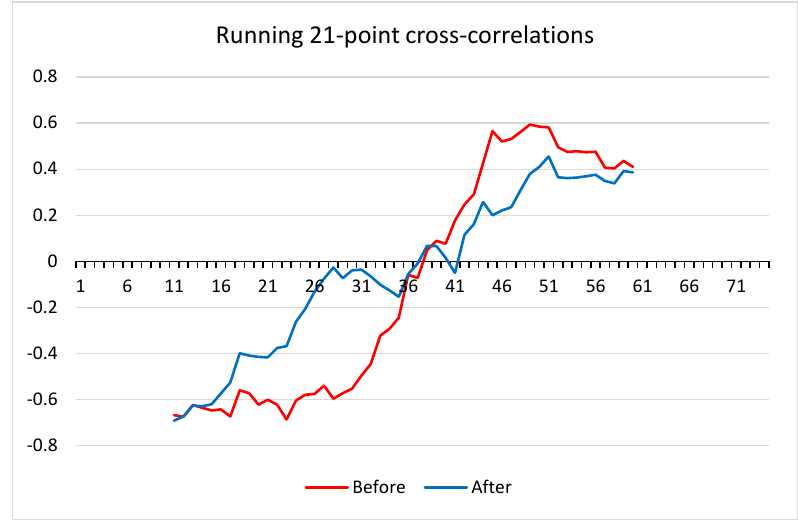
Figure 2. Running 21-point cross-correlations before and after the shifts in the variance and mean are added to the time series.